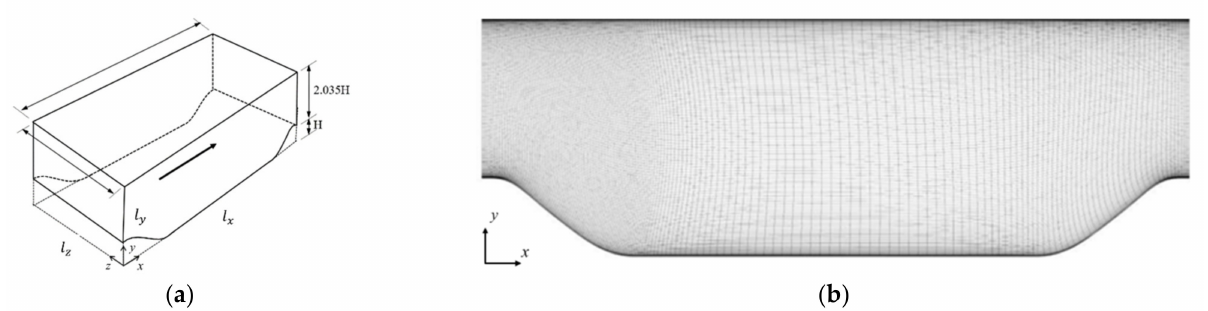
Figure 1. Schematics of the periodic hill ( a ) and the corresponding mesh configuration ( b ).